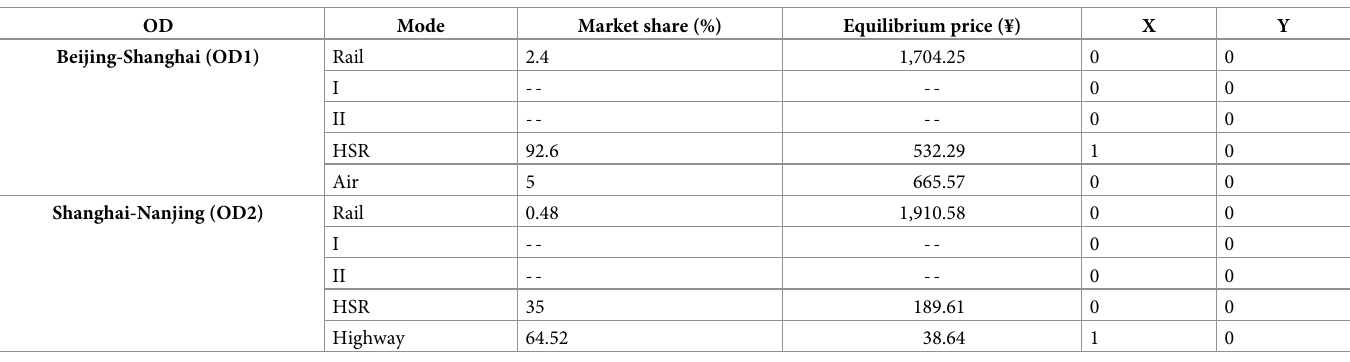
Table 4. Base-case